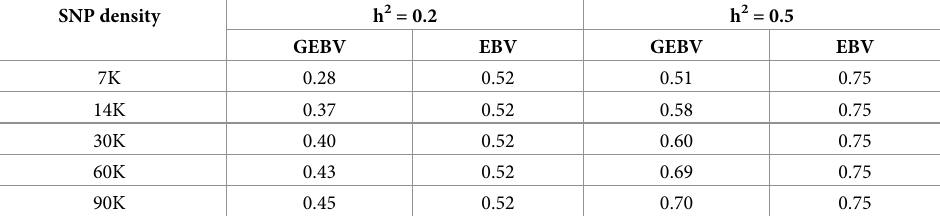
Table 4. Accuracies of GEBVs for different numbers of makers in different sizes of SNP panel: 7K, 14K, 30K, 60K or 90K SNPs used in the prediction population for low (h 2 = 0.2) and high (h 2 = 0.5) heritabilities, compared with the accuracy of equivalent EBVs. Marker effects were estimated using 1,000 clones in the training population. SNP density h 2 = 0.2 h 2 = 0.5